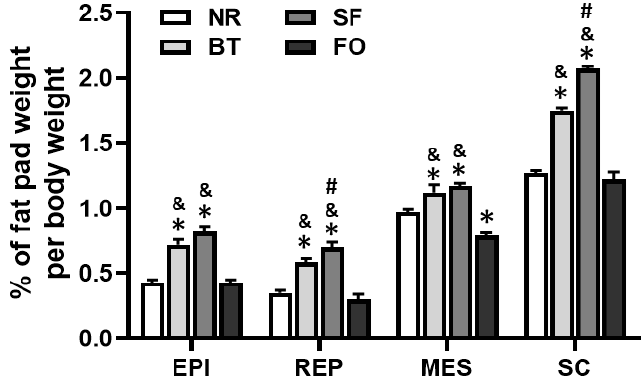
Figure 4. Comparison of each fat pad weight expressed as a percentage of body weight in rats after different diet feeding for 4 weeks. EPI: epididymal fat pad; REP: retroperitoneal fat pad, MES: mesenteric fat pad; and SC: subcutaneous fat pad. Values are expressed as mean ± SE.; n = 6, * p < 0.05, vs. normal rodent diet (NC); & p < 0.05, vs. fish oil (FO); and # p < 0.05, vs. beef tallow (BT).